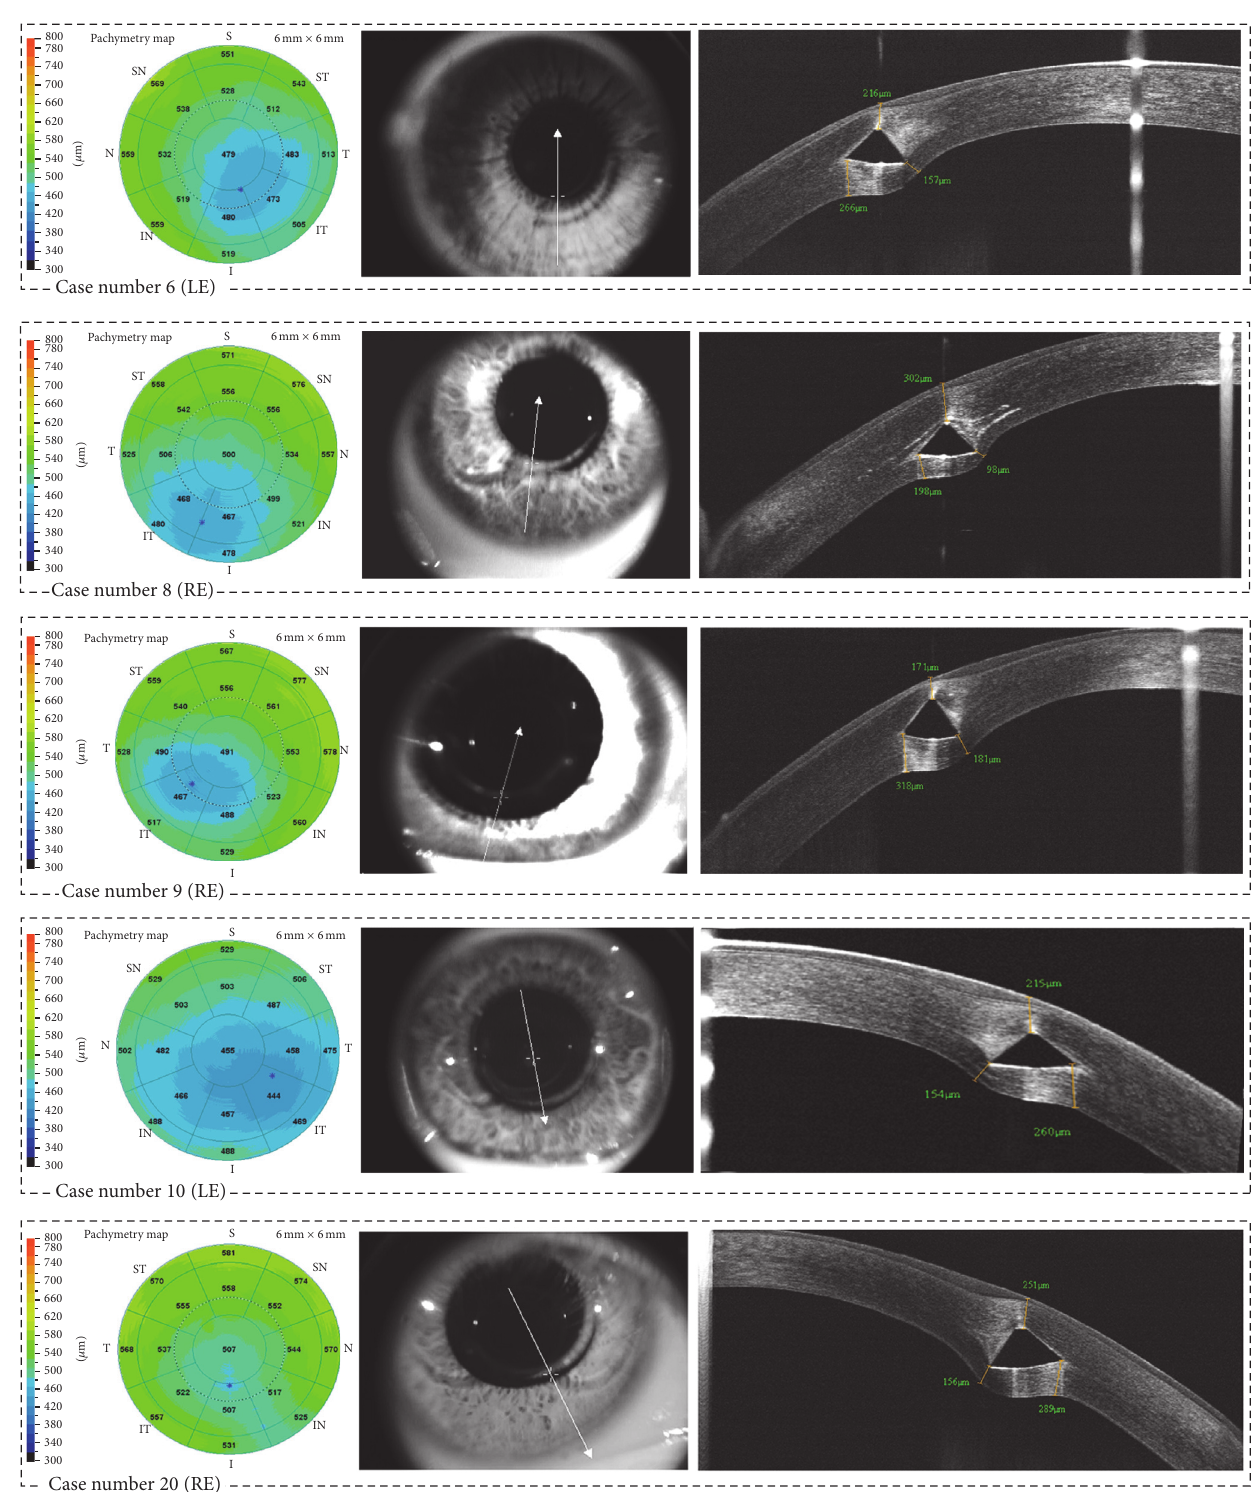
Figure 8: The pachymetry map and the Keraring OCT images (enface and high definition line) of cases # 6, # 8–10, and # 20. LE = left eye; RE = right